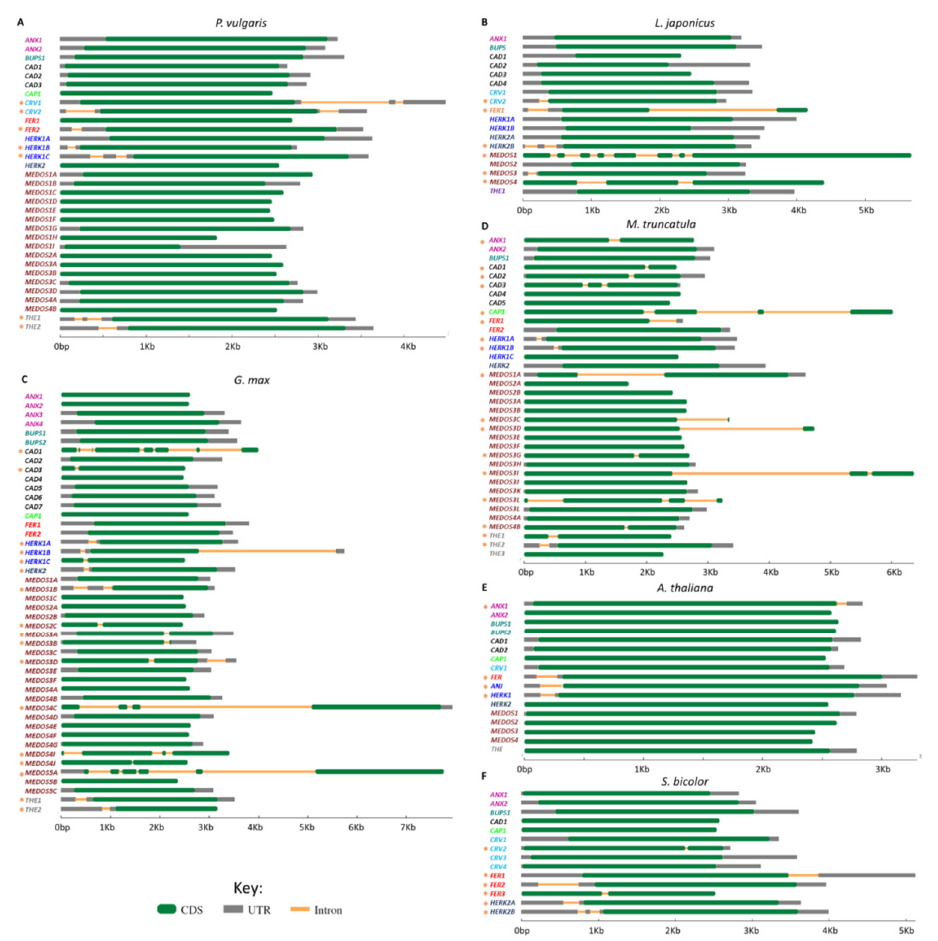
Figure 4. Gene structure of the CrRLK1L subfamily genes in four legumes, A thaliana , and S. bicolor . The exon–intron structures of all CrRKL1L genes from ( A ) P. vulgaris , ( B ) L. japonicus , ( C ) G. max , ( D ) M. truncatula , ( E ) A. thaliana , and ( F ) S. bicolor were analyzed using the Gene Structure Display Server database. Exons (CDS), introns, and untranslated regions (UTRs) are represented according to the key. Gene names are highlighted in colors as follows: ANX in purple, BUPS in green, CAD in black, CAP in lime, CRV in blue, FER in red, HERK1 ( ANJ ) in blue, HERK2 in dark blue, MEDOS in brown, and THE in gray. Orange asterisks to the left of the names indicate genes with introns.